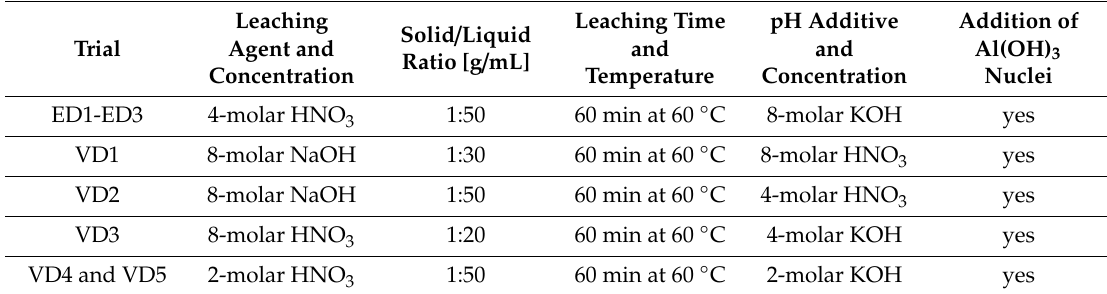
Table 9. Parameter combinations of the main trials.